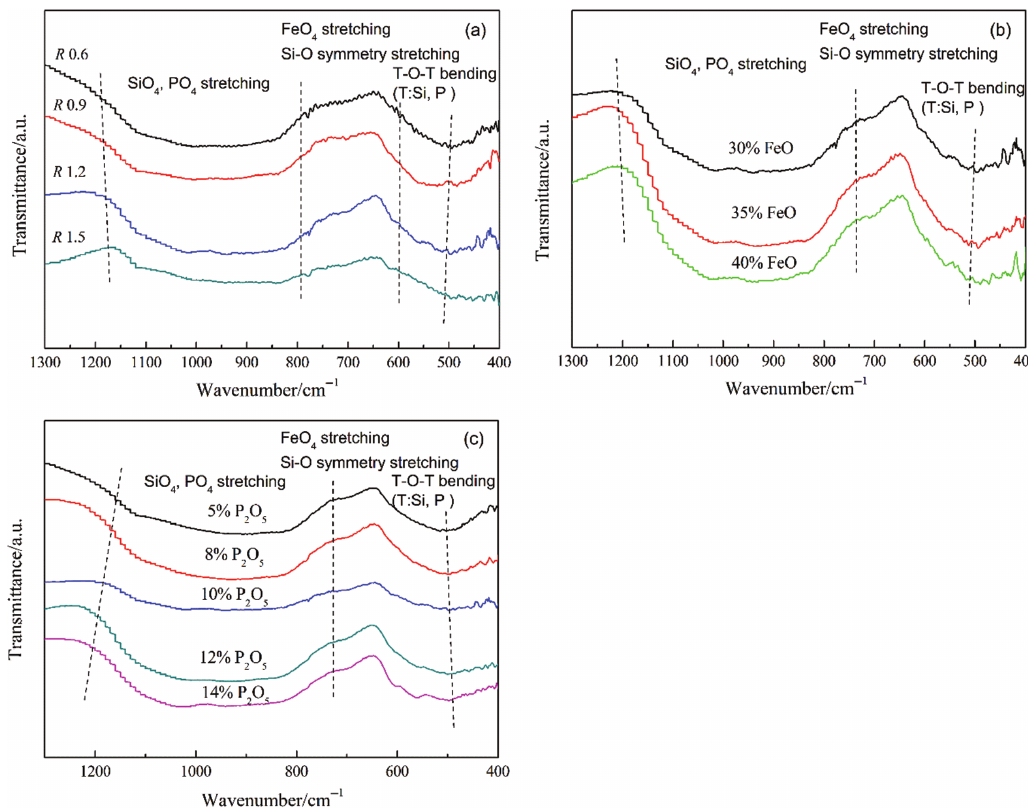
Figure 5: FT-IR spectra of slag samples with varying (a) basicity, (b) FeO content and (c) P 2 O 5